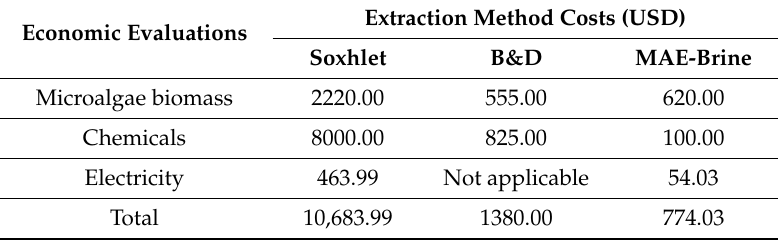
Table 6. The cost assessment for production 1 kg of lipids from Nannochloropsis sp. microalgae using di ff erent extraction